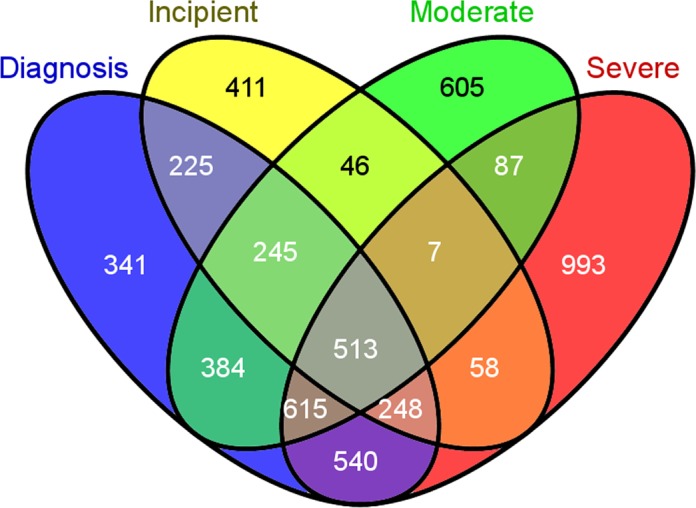
Four-set Venn diagram of the overlap of significantly differentially expressed genes (SDEGs) in GSE28146 gene expression datasets.Courtesy: Oliveros, J.C. (2007–2015) Venny. An interactive tool for comparing lists with Venn's diagrams. Publicly available at http://bioinfogp.cnb.csic.es/tools/venny/index.html.